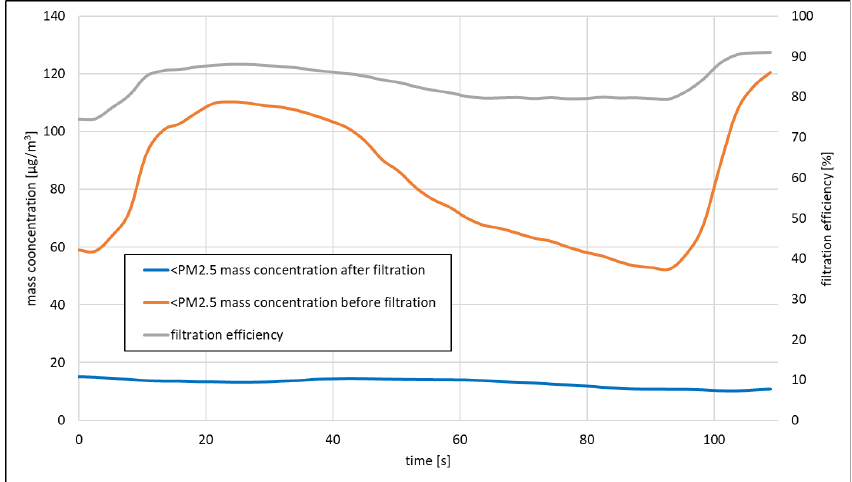
Figure 8. Mass concentrations of dust ≤ PM 2.5 with a higher relative humidity in air after application of H13 HEPA filter regarding filtration efficiency (temperature: 15 °C, relative humidity: